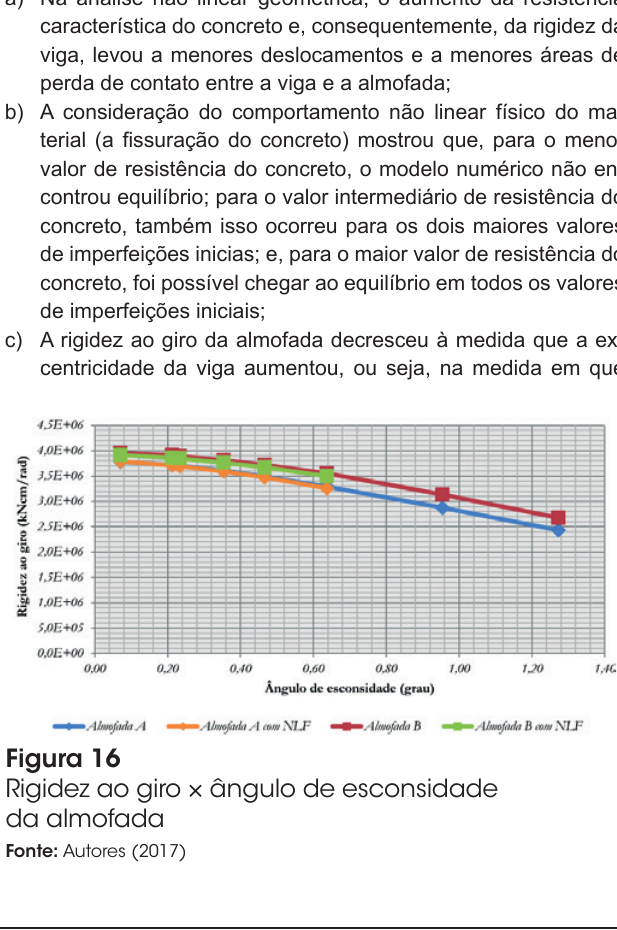
Figura 16 apresentam as rigidezes ao giro obtidas para cada viga, considerando ou não a não linearidade física do concreto. Não há resultados para as vigas V7 e V8, pois a solução não convergiu no modelo numérico dessas vigas quando o valor da resistência